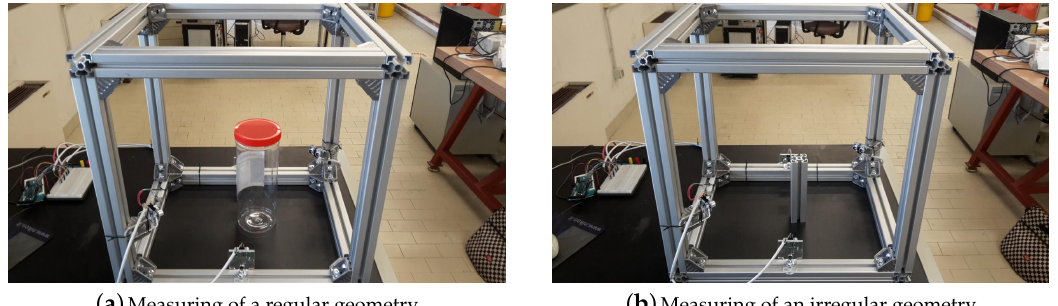
Figure 2. Experimental test-rig used for the preliminary analysis made of Bosh aluminum profiles on which the SRF05 sensors were installed.